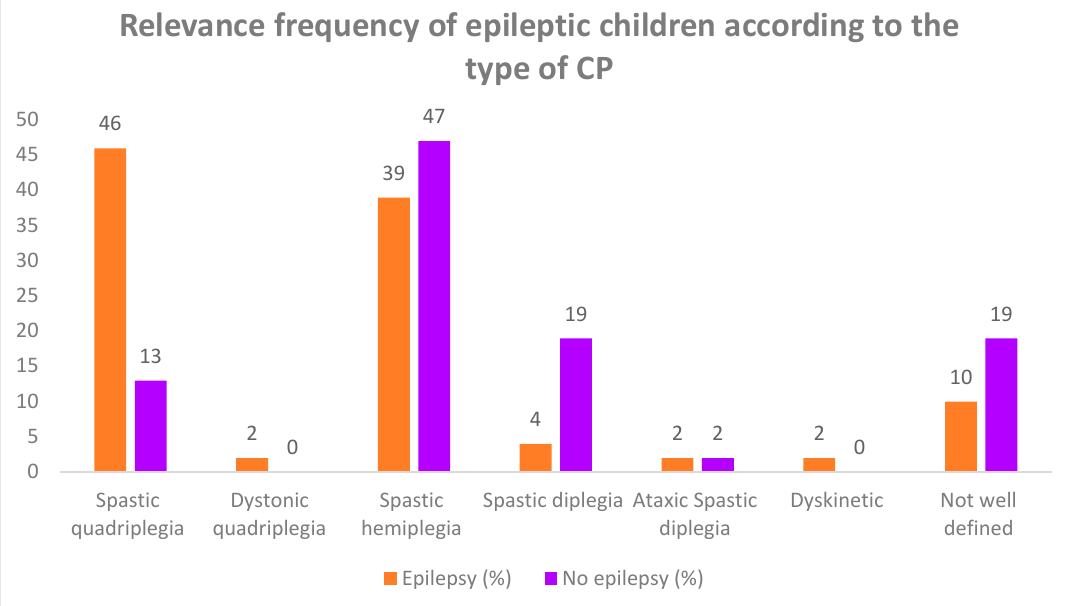
Figure 3 . Absolute frequency of epileptic children according to the type of CP.